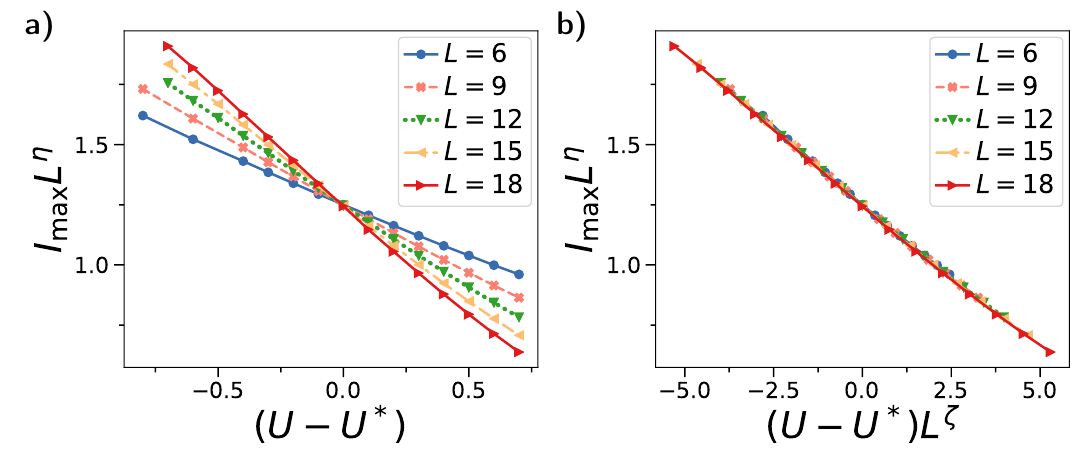
Figure 4: Finite size scaling of the persistent current for N = 3. a) Finite size critical crossing of I at U ∗ = 2.9 b) Data collapse. L = 6,9 were calculated with exact max diagonalization; larger L were obtained with DMRG. The critical indices are η ≈ 0.2 and ζ ≈